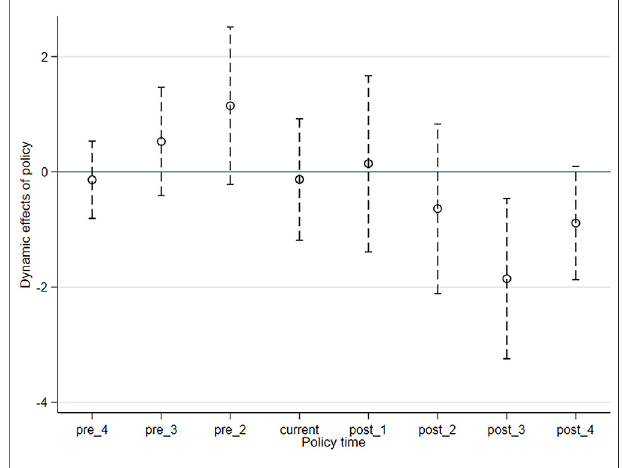
FIGURE 2 | Parallel trend